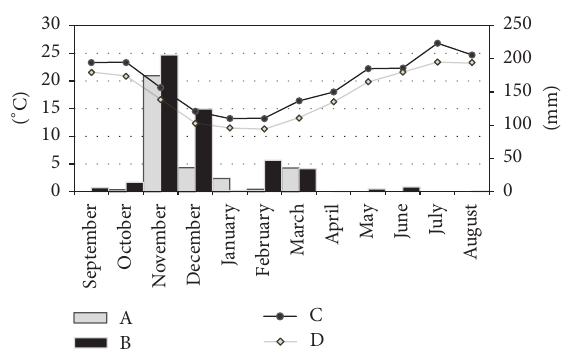
Figure 2: Mean temperatures and precipitations during 2014-2015 for both study sites in Morocco. (A) mean precipitations (mm) for 2nd site; (B) mean precipitations (mm) for 1st site; (C) mean temperatures ( ∘ C) for 2nd site; (D) mean temperatures ( ∘ C) for 1st